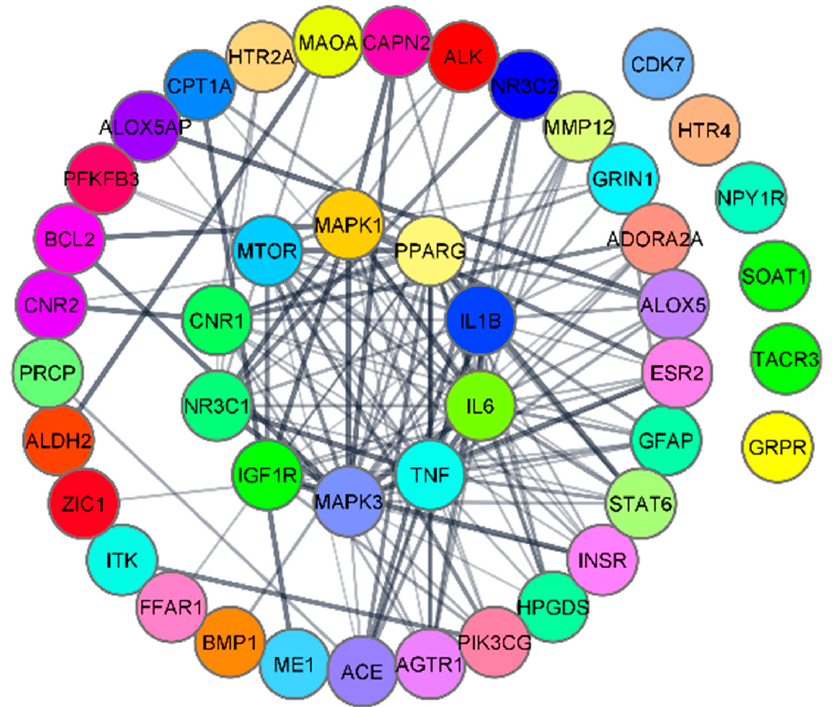
Figure 3. PPI network showing interaction among overlapping genes. The central nodes represent top ten interacting genes .